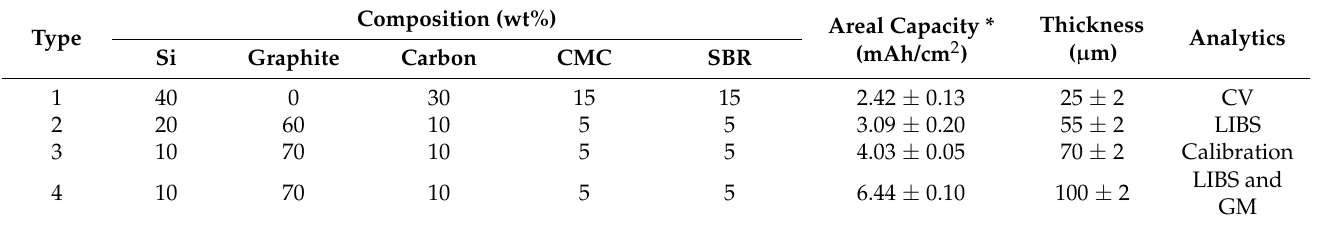
Table 1. Chemical composition and theoretical capacity of the prepared silicon and Si/C